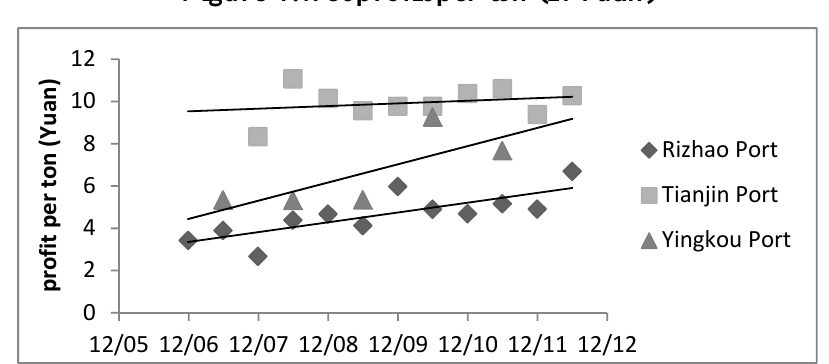
Figure 4. Net profit per ton (in